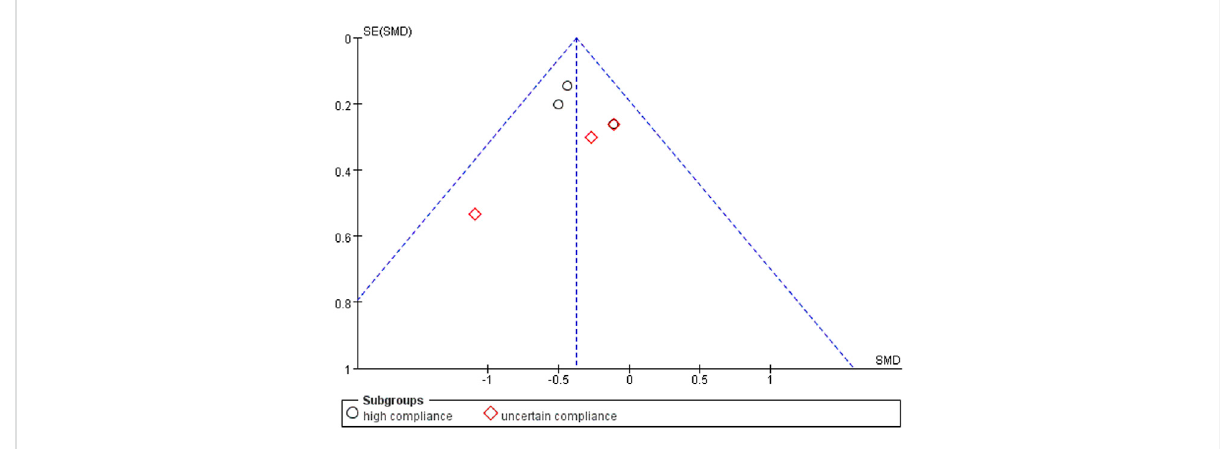
FIGURE 10 Funnel plots for stiffness; symmetric funnel plots showed no publication bias. SE, standard error; SMD, standardized mean